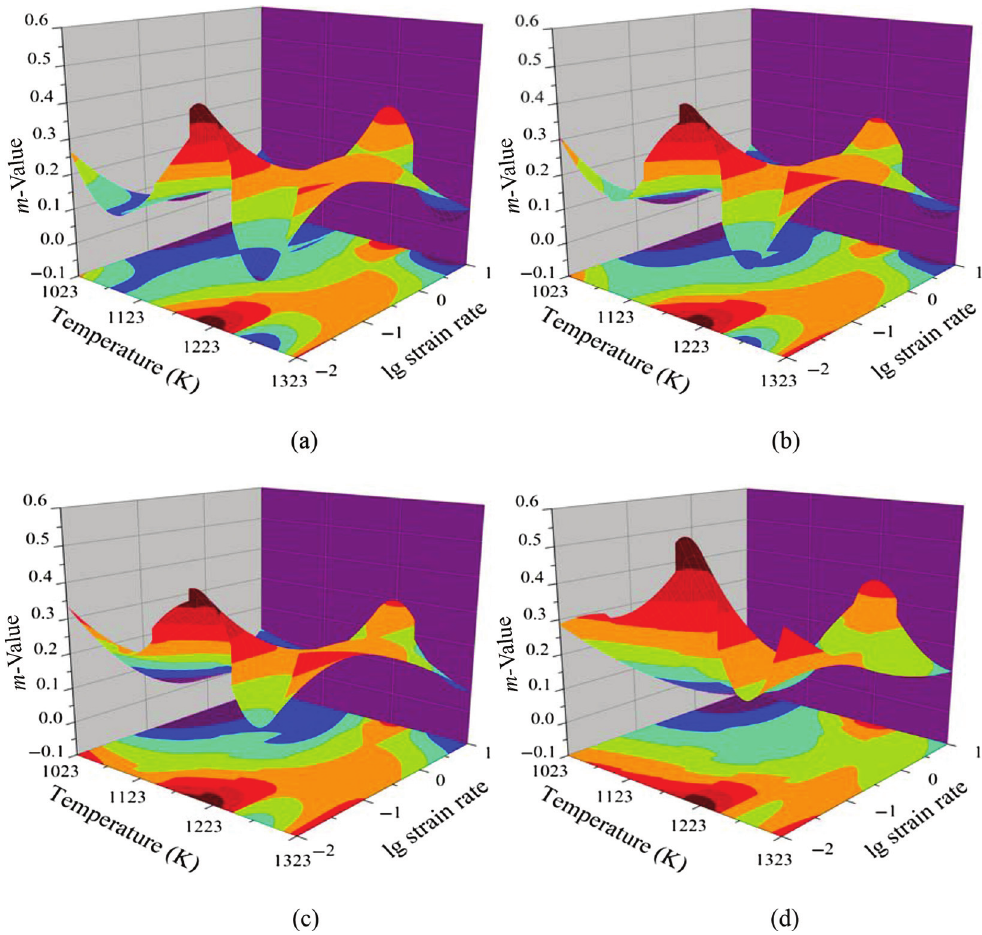
Figure 5 : The response 3D surface of m -value on temperature and strain rate as the true strain: (a) " ¼ 0 : 3 , (b) " ¼ 0 : 5 , (c) " ¼ 0 : 7 , (d) " ¼ 0 : 9 .